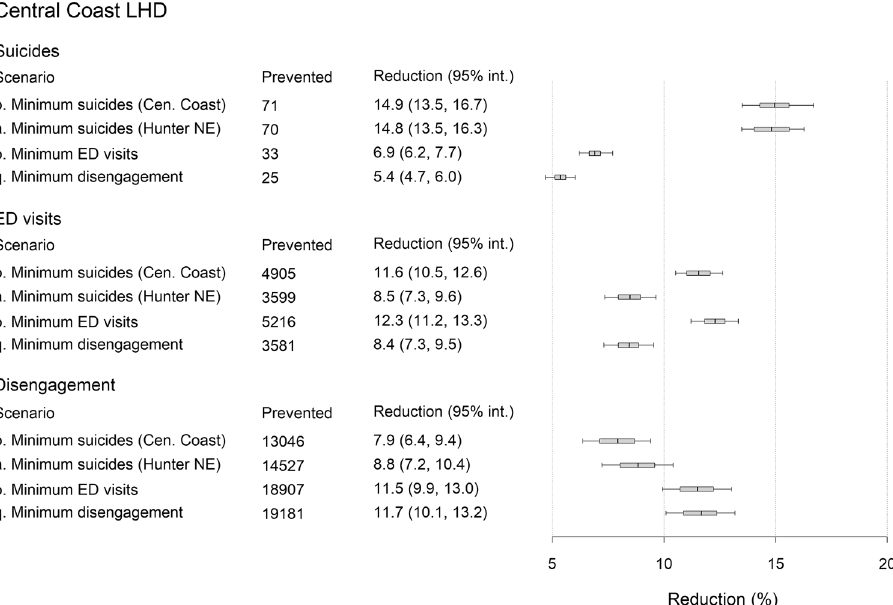
Figure 3. Projected reductions (%, relative to business as usual) in total numbers of suicide deaths, mental health-related emergency department (ED) presentations, and patients disengaging from services in the Central Coast Local Health District (LHD) over the period 2021–2031. Results are shown for the optimal intervention scenario(s) for each outcome (see Table 2 for intervention scenario details). Mean percentage reductions and 95% intervals reported in the rightmost column were derived from the distributions of projected outcomes calculated in the sensitivity analyses (note that the 95% intervals provide a measure of the impact of uncertainty in the assumed intervention and pandemic effects, but should not be interpreted as confidence intervals). Numbers of cases (i.e., suicides, ED presentations, and disengagements from services) prevented were obtained assuming the default parameter values. Mean percentage reductions and 50% and 95% intervals are plotted on the